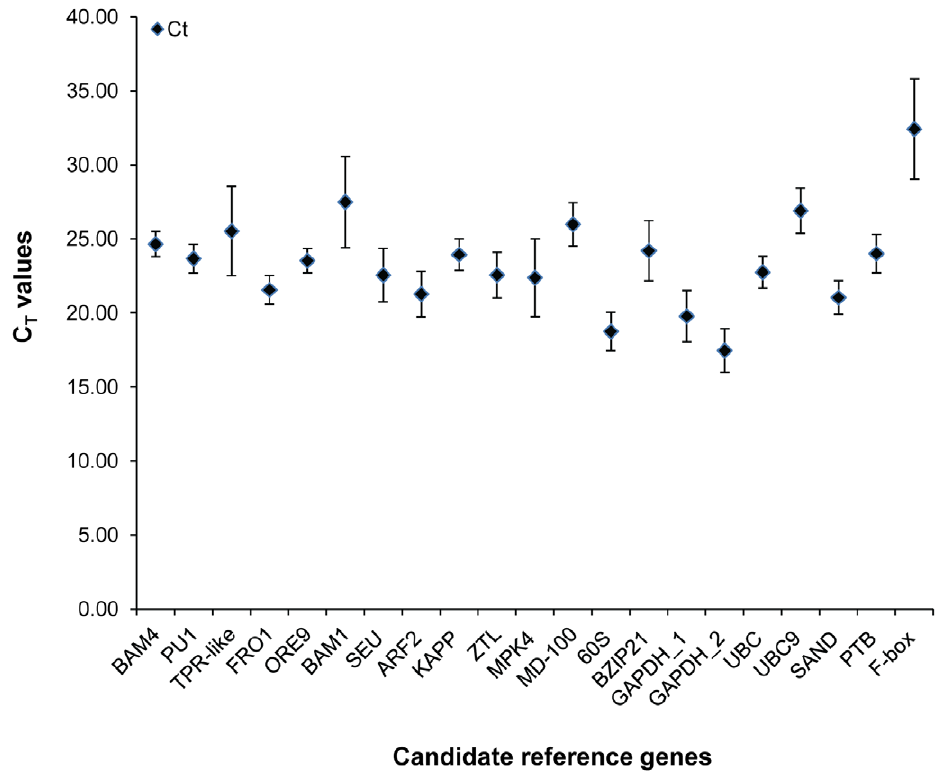
Figure 4. Average cycle threshold (C T ) values for 21 candidate reference genes. The filled diamond symbol indicates median C T values. The bars indicate standard deviation.